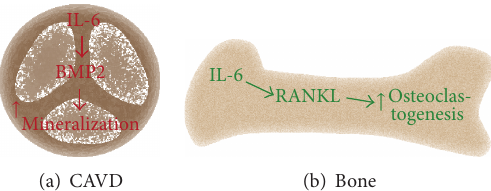
Figure 2: The calcification paradox could be explained by interleukin-6 (IL-6), which mediates the mineralization of the aortic valve and in bone activates